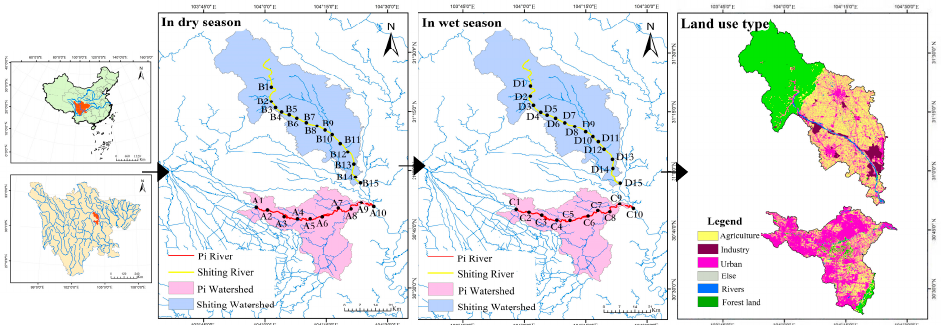
Figure 1. Distribution of sampling sites and land types in different water periods (The data set of Chinese Map was provided by the Data Center for Resources and Environmental Sciences, Chinese Academy of Sciences (http://www.resdc.cn, accessed on 10 March 2021)).